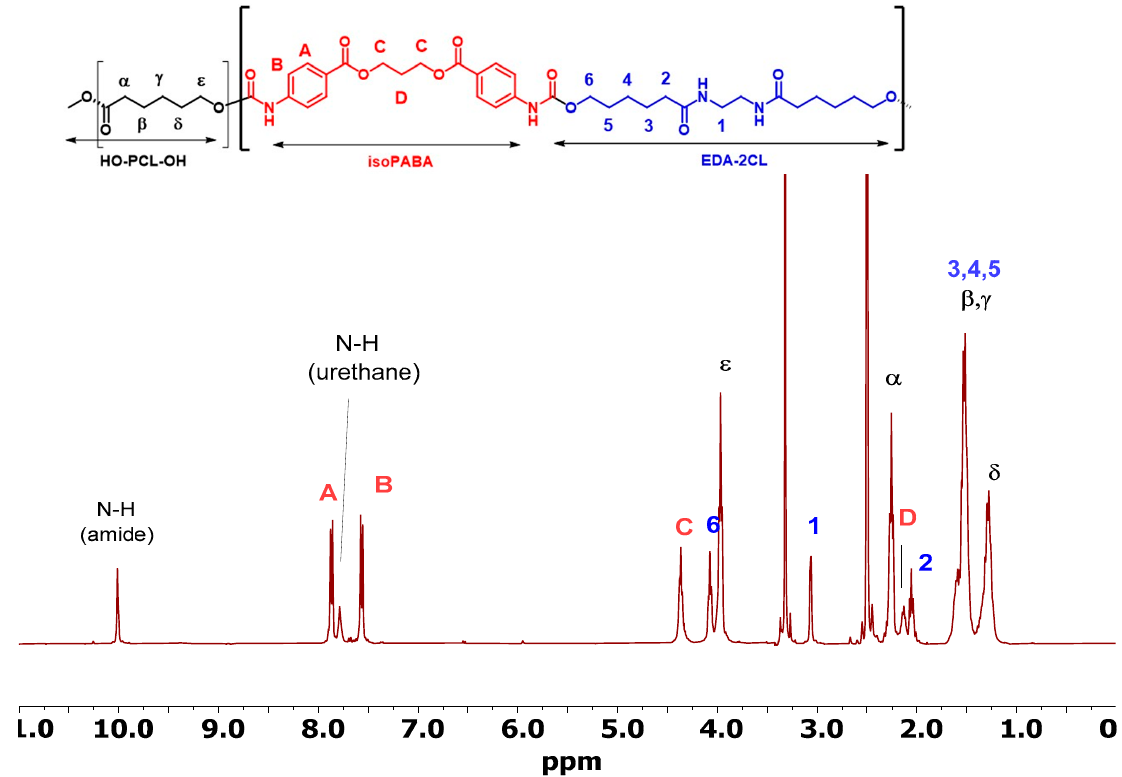
Figure 3. 1 H-NMR spectrum and chemical structure of poly(ester-urethane) PUP-2E-50 in deuter- ated DMSO.